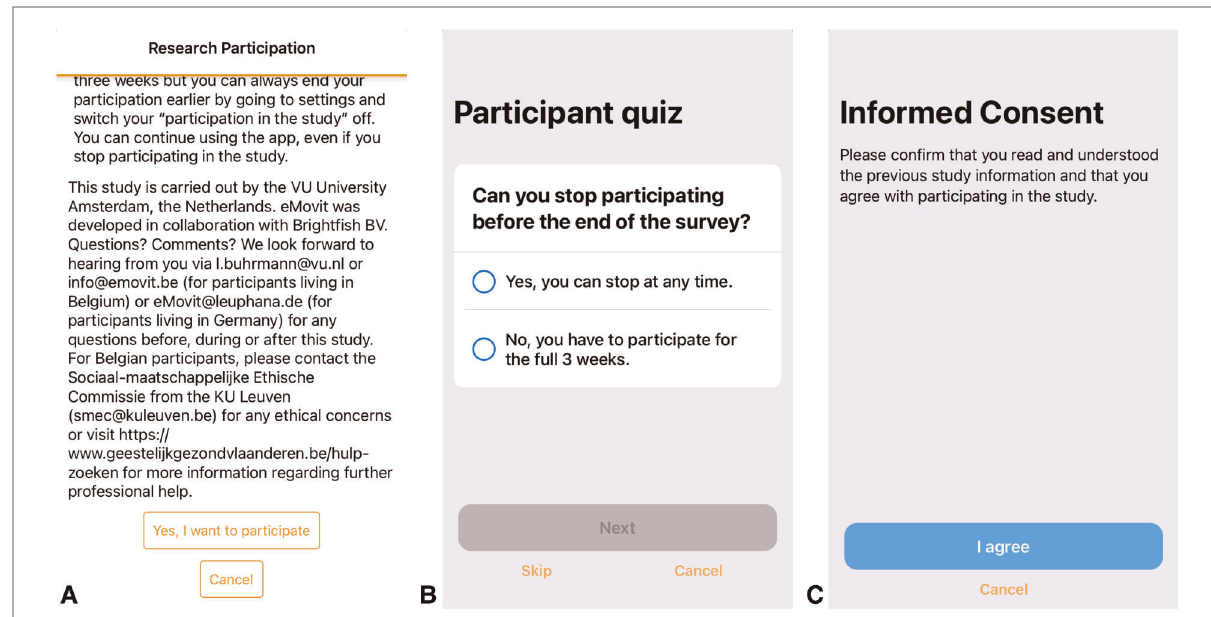
FIGURE 2 Screenshots of the research information and consent screens of the eMovit app, showing study information ( A ), a 3-item multiple choice participant quiz evaluating their understanding of study participation ( B ), and con fi rmation of consent ( C ). Note. The eMovit app was developed by Brigth fi sh BV for VU Amsterdam. © 2022 VU Amsterdam. All rights reserved.